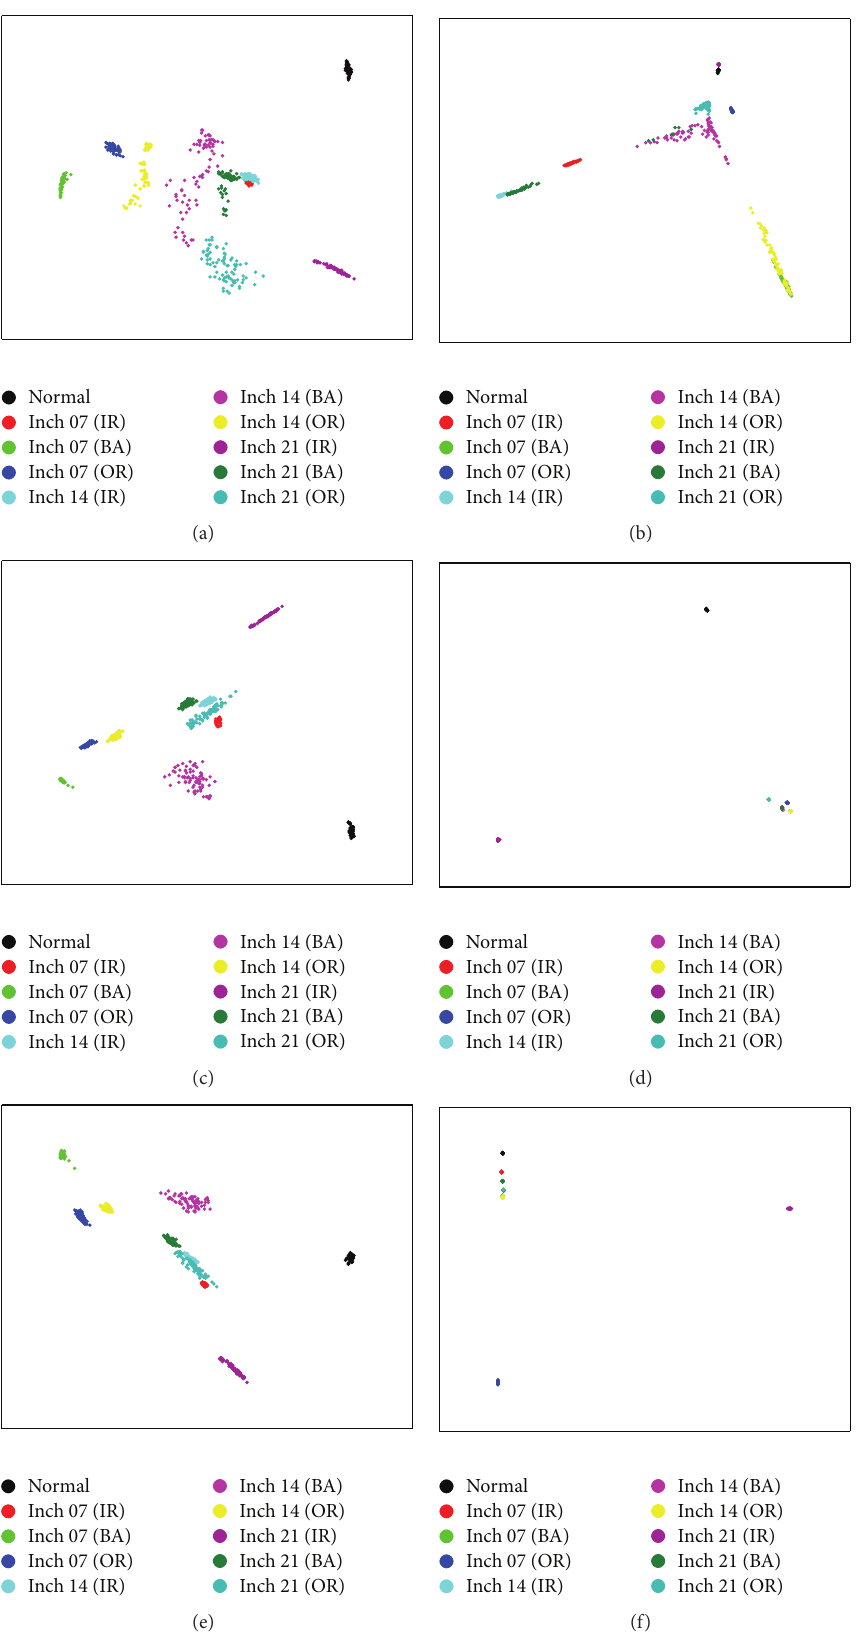
Figure 3: Two-dimensional representation of bearing data under 2HP motor load by each method: (a) PCA; (b) KPCA; (c) LDA; (d) KDA; (e) TR-LDA; (f)